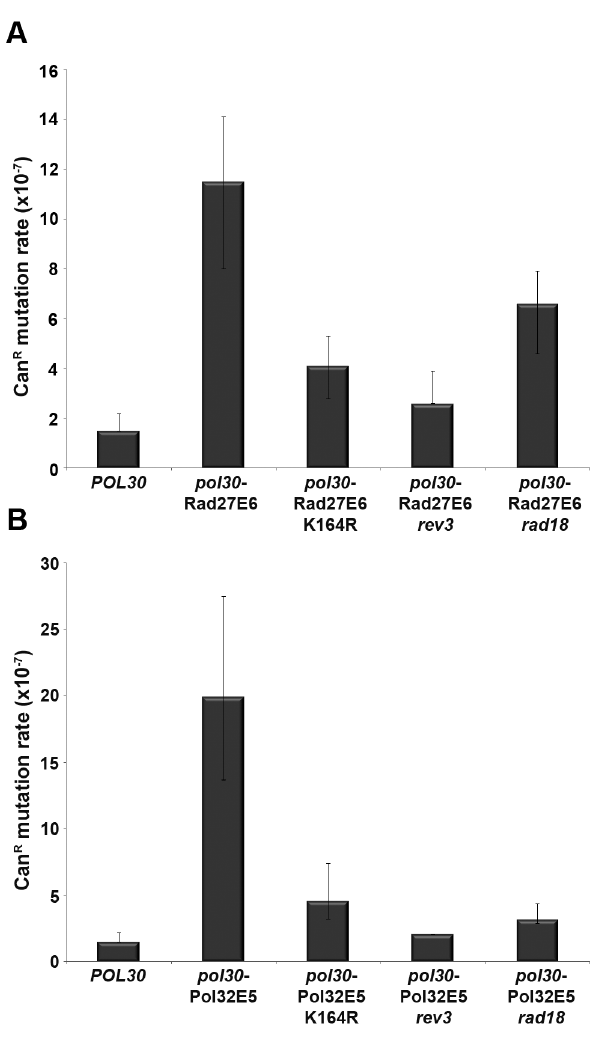
Figure 7. The increase in the spontaneous mutation rate of PCNA mutants is dependent upon Pol f recruitment and ubiquitination of PCNA at K164. The effects of the rev3 , rad18 , and K164R PCNA mutations on the spontaneous mutator phenotype of PCNA mutants with increased affinity for Rad27 (A, pol30 -Rad27E6) and Pol32 (B, pol30 -Pol32E5) are shown. The data are rates of Can r mutation and are medians representing values that are within the 95% confidence limits for at least 25 independent determinations. The exact values of the spontaneous mutation rate in the different strains are presented in Table 2.